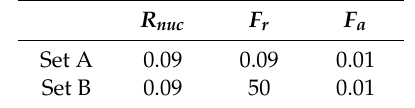
Table 3. Di ff erent values of coe ffi cients used in the